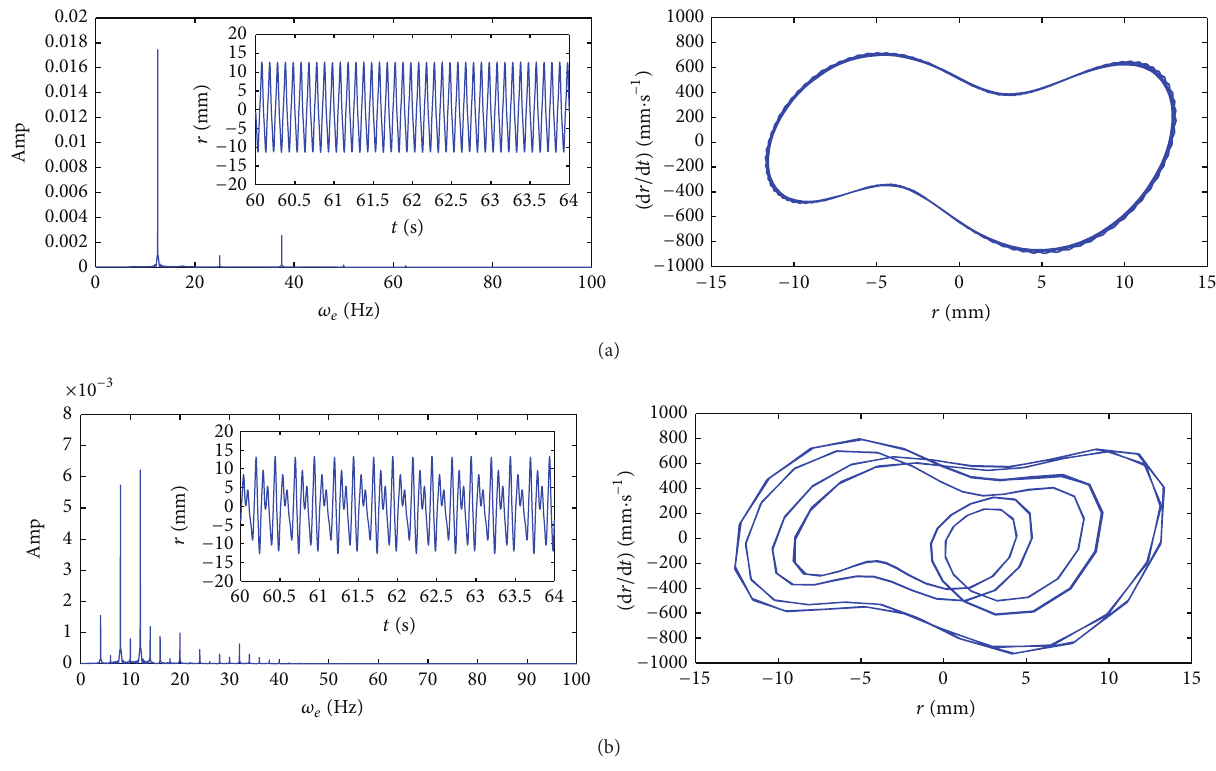
Figure 18: Experimentally obtained time series and frequency spectrum (left), and phase trajectories (right) for 𝜔 𝑒 = 12 Hz with different 𝑍 = 2𝑔 and (b) 𝑍 = 2.1𝑔 𝑍 𝑒 : (a) 𝑒 𝑒